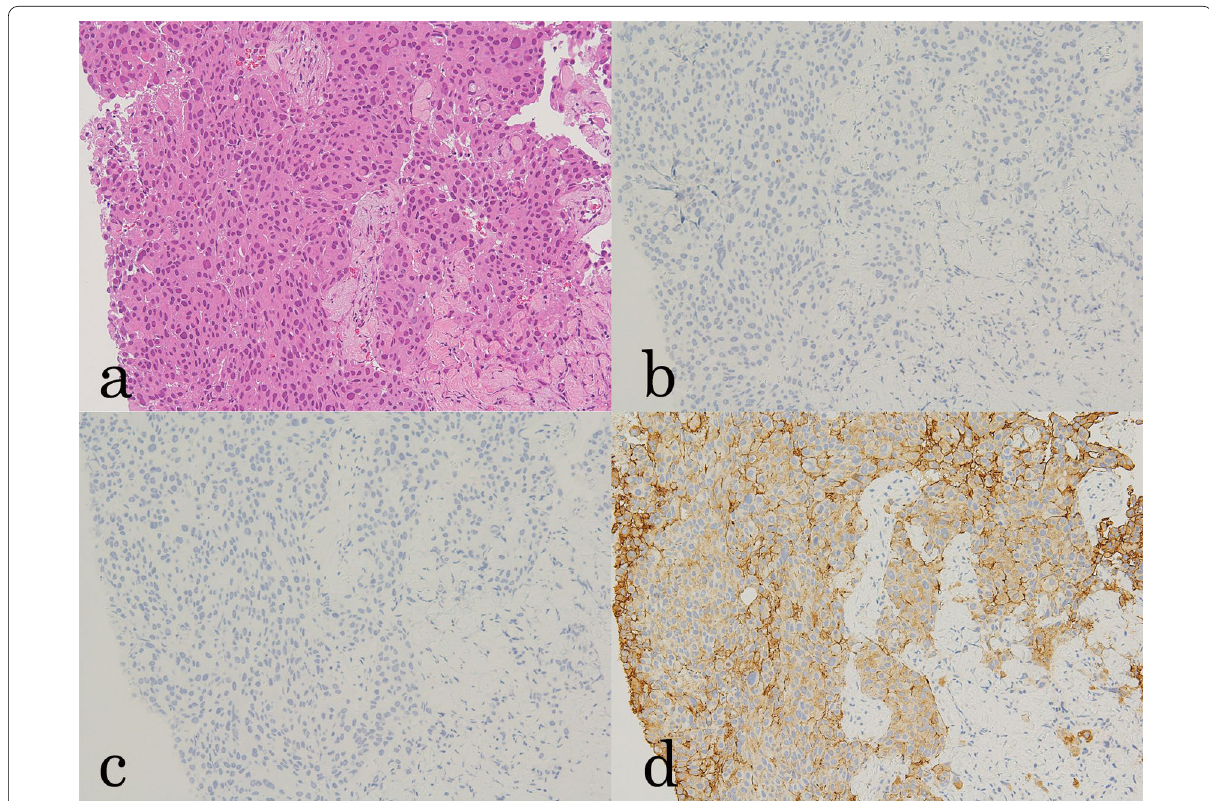
Fig. 1 Histopathological examination of the breast tumor. a HE staining revealed invasive ductal carcinoma of the breast, histological grade III ( magnification). b ER negative (